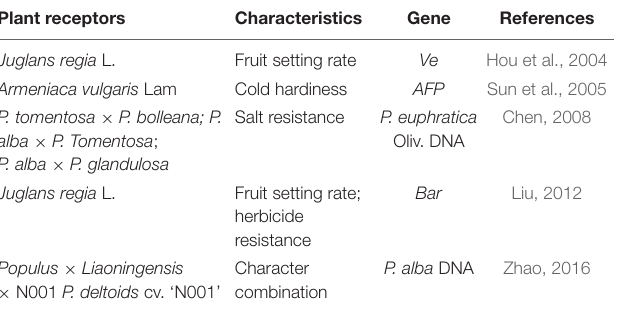
TABLE 4 | Application of pollen tube passage method in forest